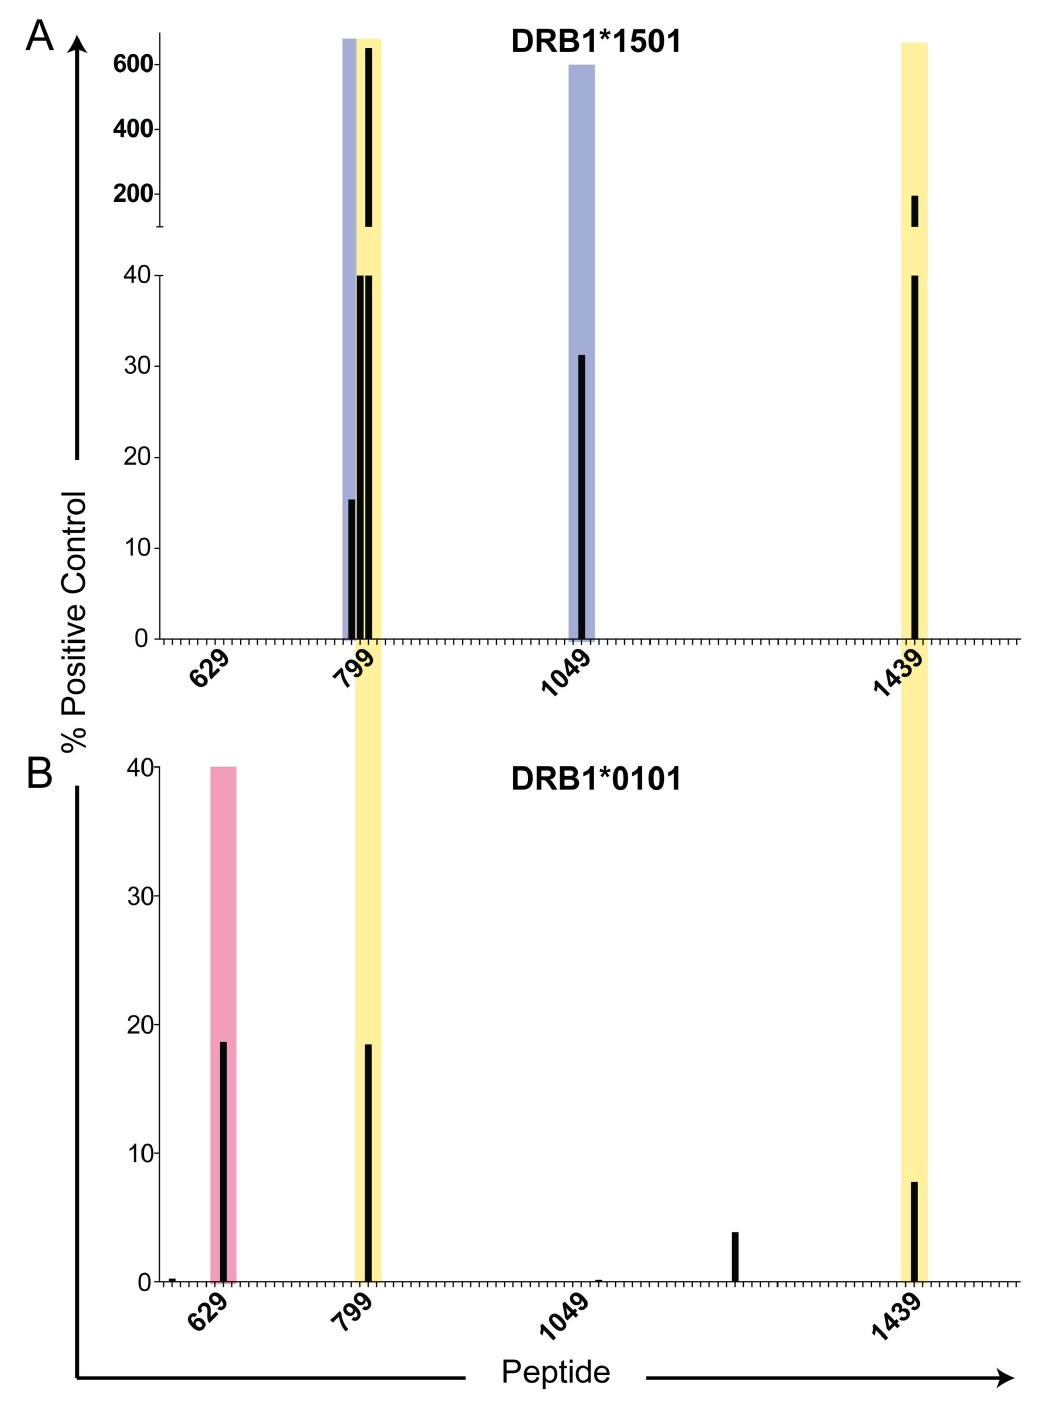
Figure 3. α1(V) peptide binding to HLA-DR1 and HLA-DR15. ProImmune REVEAL MHC-peptide binding assay screen of 5- amino acid overlapping peptide library (101 total peptides) of the α1(V) helical domain to HLA-DR15 (A), and HLA-DR1 (B). Each MHC:peptide binding score is based on known binding of a positive control peptide and a weaker binding positive control peptide. MHC:peptide binding scores above 12% are considered positive and have potential for immunological activity. Lack of bar for a peptide represents a score of 0%. Peptide number corresponds to the location in the α1(V) AA sequence. Blue shaded areas indicate epitope regions where only HLA-DR15 bound, red shaded areas where only HLA-DR1 bound, and yellow shaded areas indicate both HLA-DR1 and –DR15 bound within that helical domain. doi: 10.1371/journal.pone.0079601.g003 PLOS ONE |